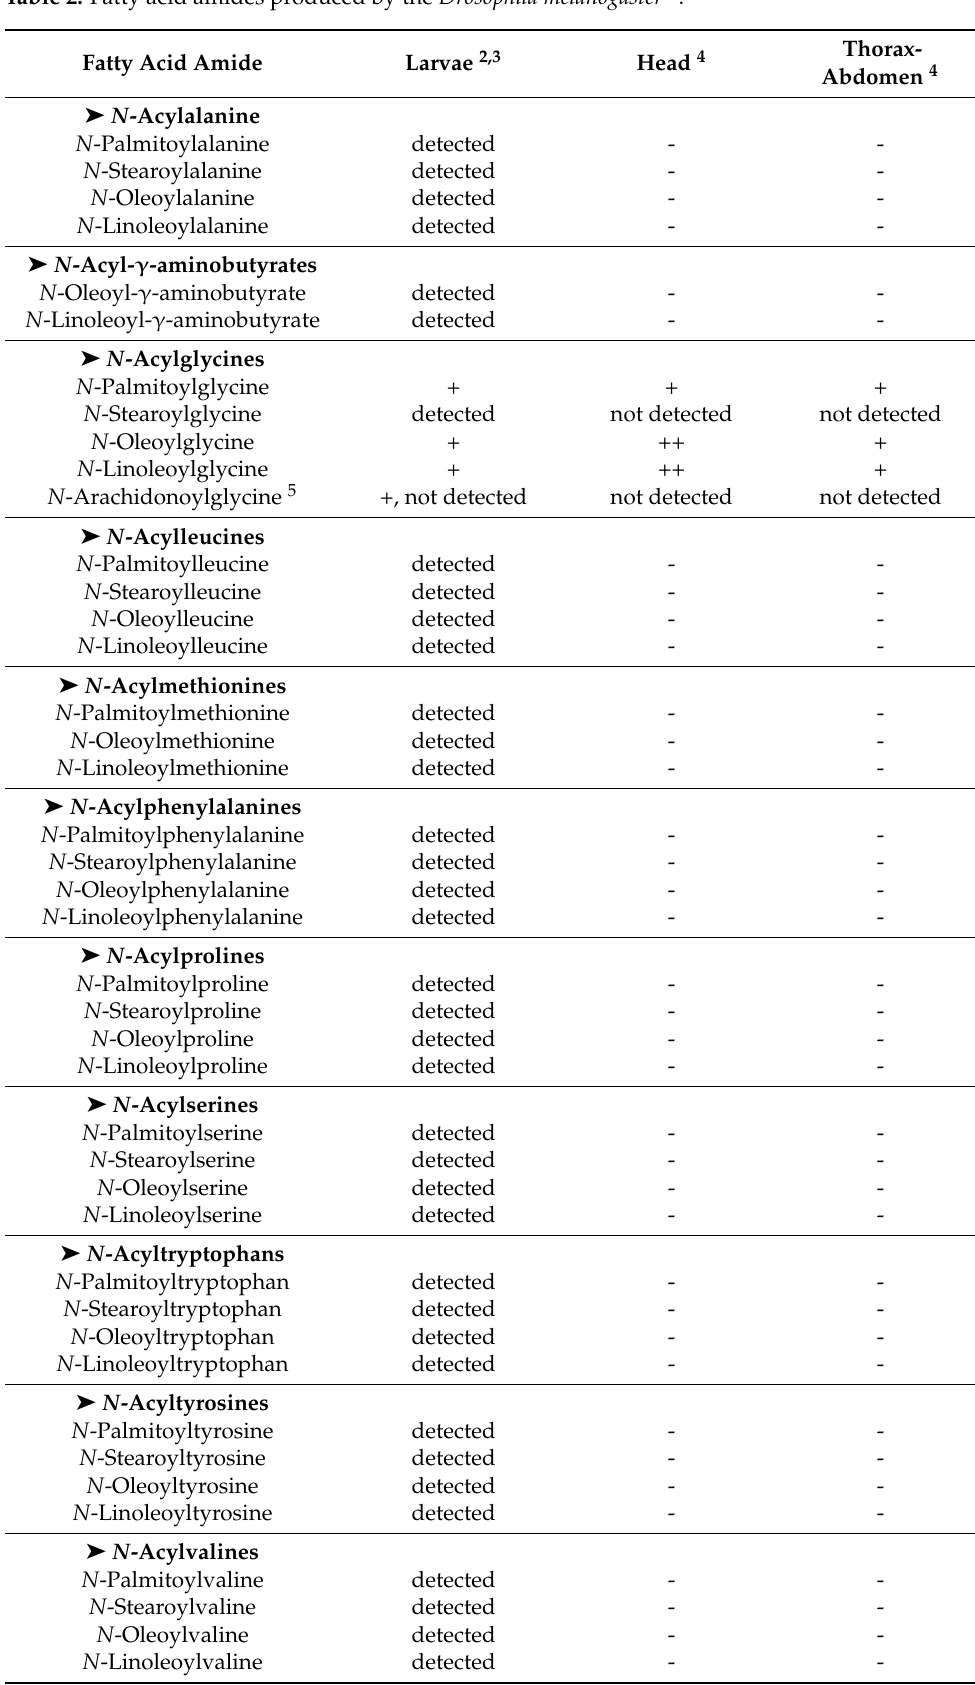
Table 2. Fatty acid amides produced by the Drosophila melanogaster 1